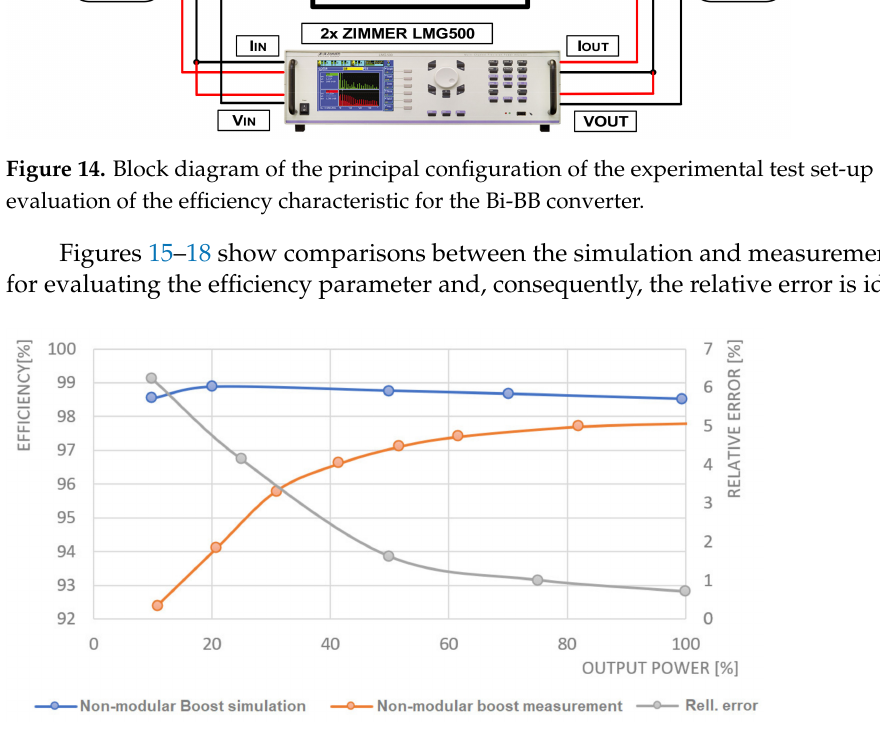
Figure 15. Comparison of efficiency characteristics for the simulation (blue) and the measurement (orange) samples and the evaluation of relative error between results in boost